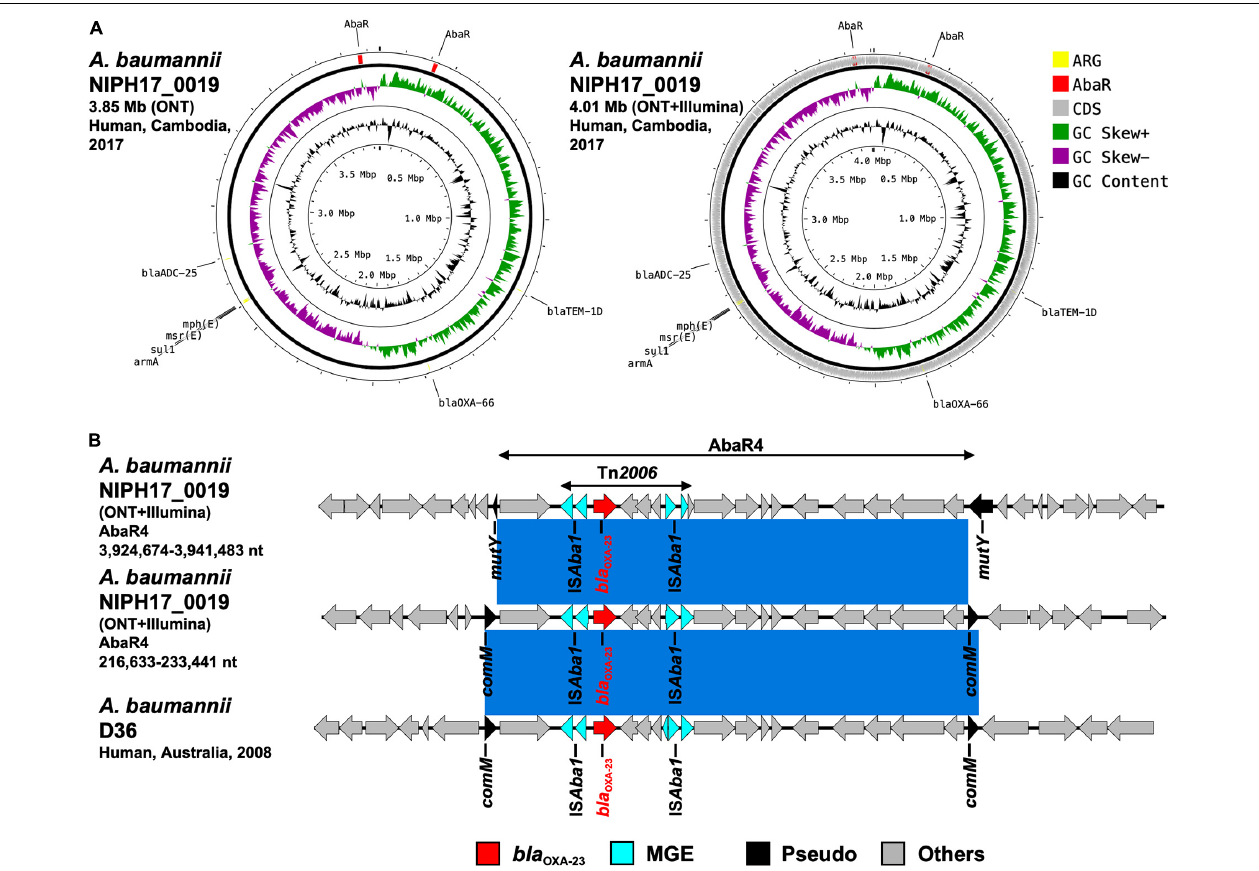
FIGURE 5 | (A) Circular chromosome representation of A. baumannii NIPH17_0019 harboring two copies of bla OXA − 23 . Both the uncorrected sequence (from on-site ONT analysis) and corrected sequence (from subsequent ONT + Illumina analysis, accession no. AP024415) are shown. Yellow, red, gray, green, purple, and black indicate AMR genes (ARG), AbaR4 with bla OXA − 23 (AbaR), other coding sequences (CDS), GC skew+, GC skew-, and GC content, respectively. (B) Linear comparison of AbaR4-containing genomic regions in A. baumannii from Cambodia and other countries. Two sets of AbaR4 with bla OXA − 23 in A. baumannii NIPH17_0019 (3,924,674–3,941,483 nt region inserted within mutY and 216,633–233,441 nt region inserted within comM in accession no. AP024415) and AbaR4 with bla OXA − 23 in A. baumannii D36 (41,312–58,123 nt region inserted within comM in accession no. JN107991) are shown. Red, blue, black, and gray arrows indicate carbapenemase gene ( bla OXA − 23 ), mobile gene elements (MGE), pseudogenes disrupted by AbaR4 insertions (Pseudo), and other genes (Others), respectively. The blue color in comparison of sequences indicates nearly 100%